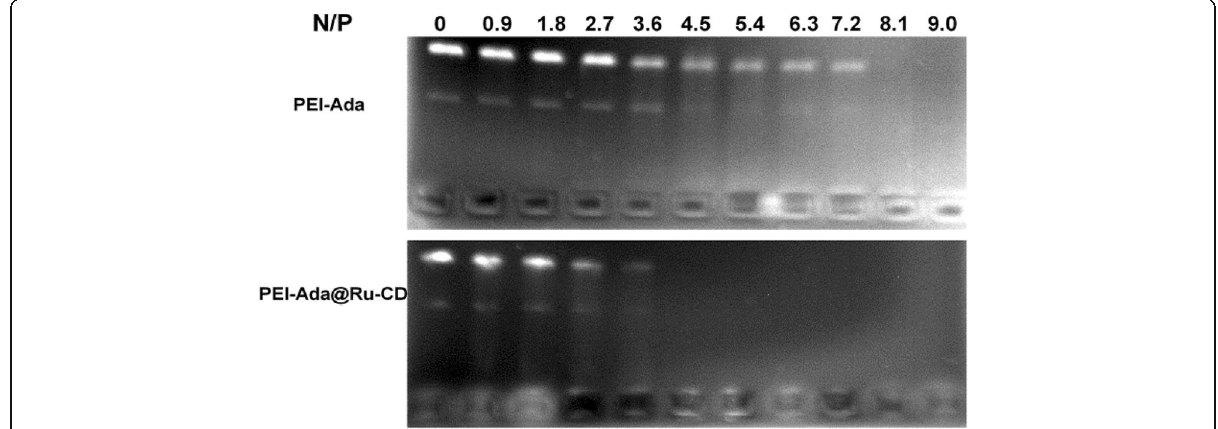
Fig. 4 Electrophoretic mobility retardation assay of the pBR322 DNA polyplexes with a PEI-Ada and b PEI-Ada@Ru-CD at different N/P